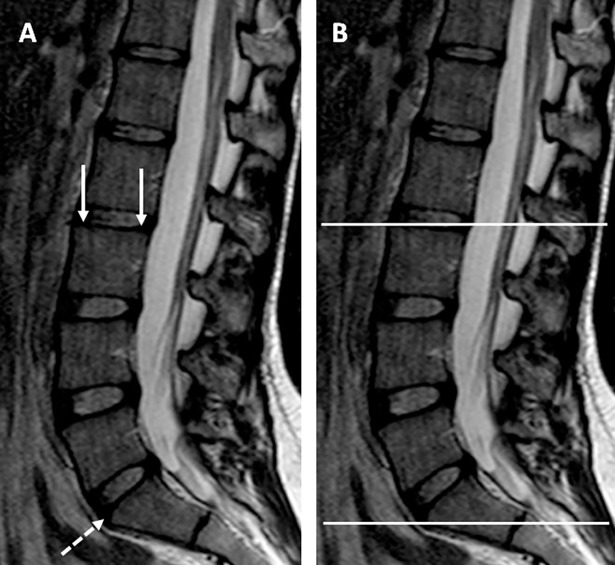
Sagittal T2-weighted image to demonstrate the superior and inferior limits of MRI axial slices acquisition.A) The white arrows point to the L3 superior endplate; the dashed arrow points the anterior margin of the S1 superior endplate. B) The white lines represent the upper and inferior limits of the block of axial slices.